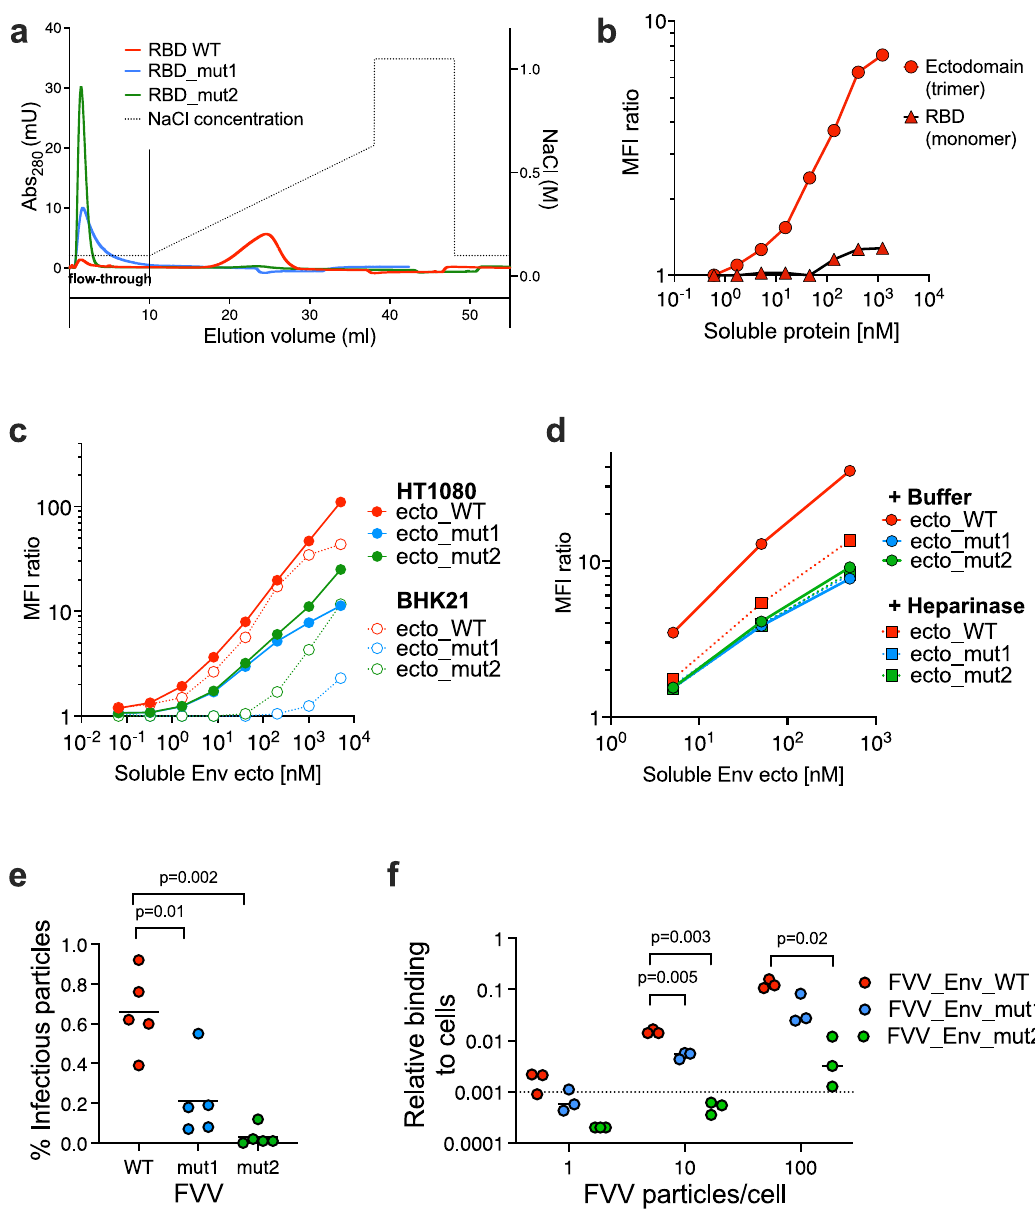
Fig.6 | TheSFV RBD residues K342, R343, R356and R369 mediateEnv binding toHS.a Heparin-Sepharosechromatogramof the recombinantSFVRBD, WT(red) and variants with mutations in HS-binding residues, mut1 (K342A/R343A) in blue, andmut2(R356A/R369A)ingreen.Dottedlineindicatessaltconcentration,plotted on the right y-axis. Source data are provided as a Source Data fi le. b Binding of recombinant WT RBD and Env ectodomains to HT1080 cells. SFV RBD and ecto- domain binding levels were expressed as the ratio of MFI from protein treated to untreated cells. To be comparable with the RBD, the concentration for the ecto- domain is calculated and plotted for the monomeric protein. Gating strategy is presentedin(Fig.S13a).SourcedataareprovidedasaSourceData fi le. c Bindingof WT,mut1(K342A/R343A),andmut2(R356A/R369A)recombinantEnvectodomains toHT1080andBHK-21cells.SFVEnvbindingleveltolivesinglecellswasexpressed as the ratio of MFI from protein treated to untreated cells (Fig. S13b). Mean from